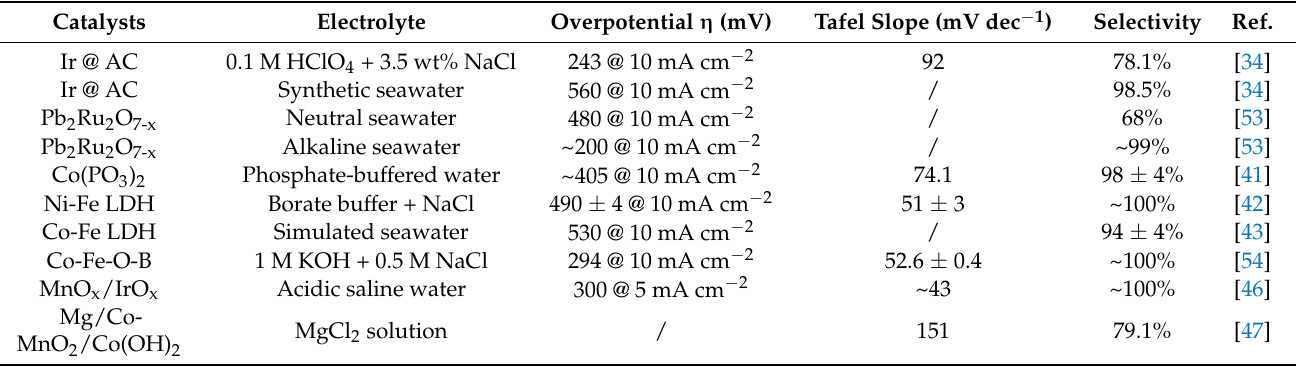
Table 1. Electrocatalytic performance of well-developed electrocatalysts with high selectivity. Catalysts